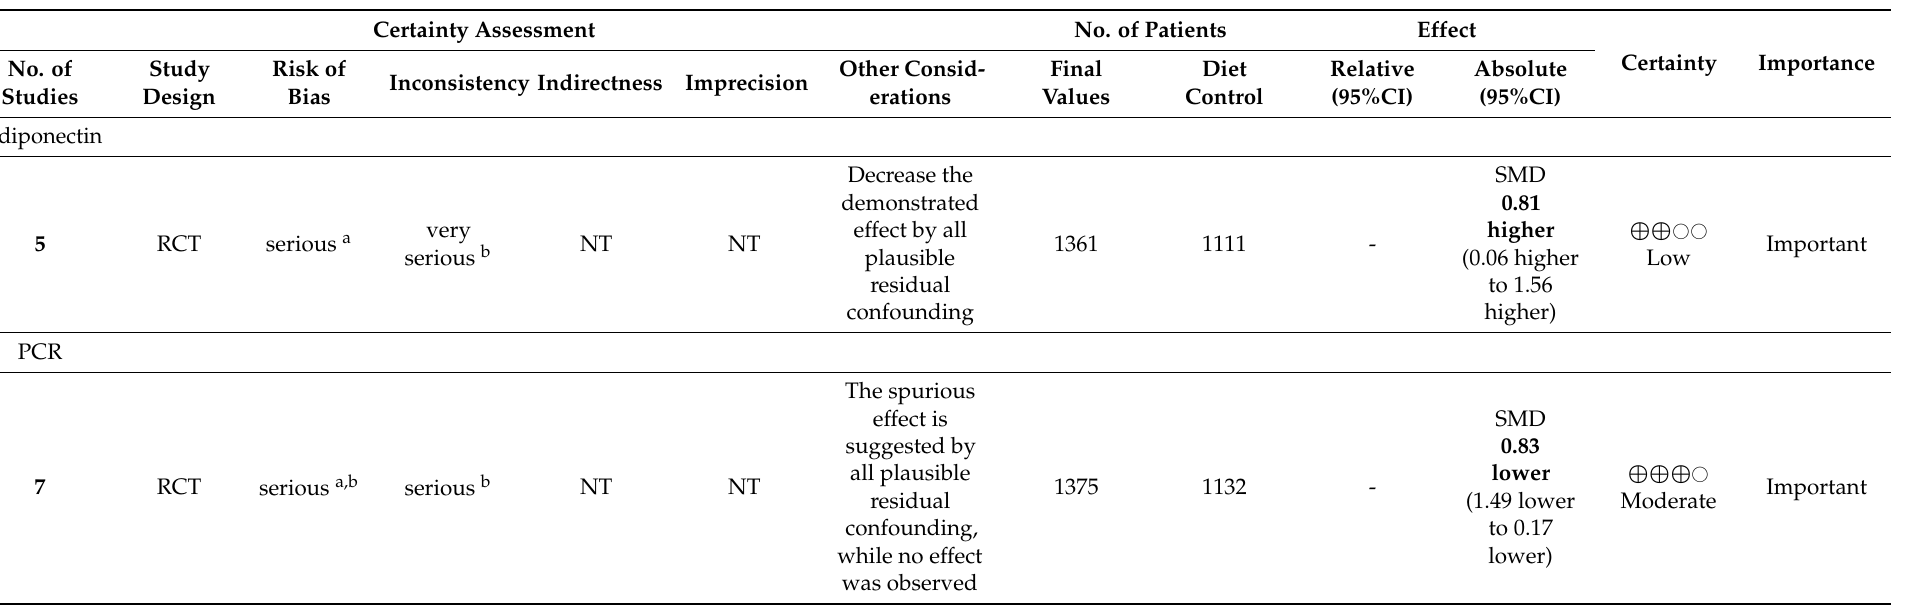
Table 2. Grading of Recommendations, Assessment, Development, and Evaluation (GRADE) evidence profile and summary of findings. Certainty Assessment No. of Patients Effect